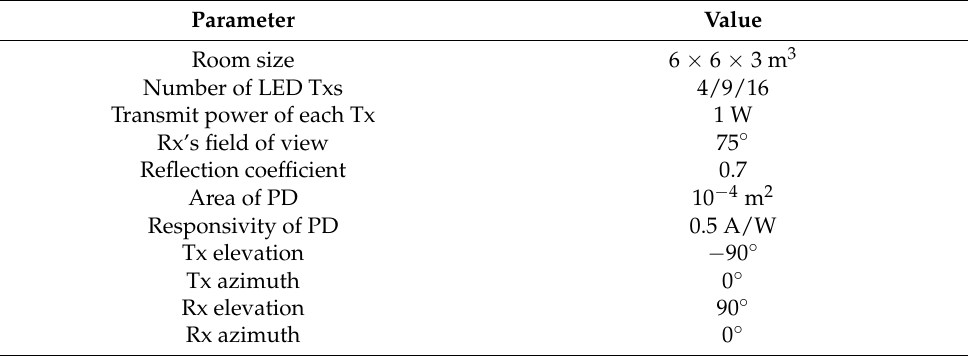
Table 2. The key parameters for the indoor VLP